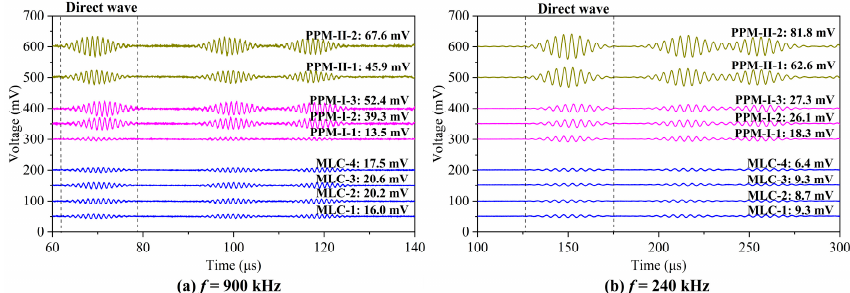
Figure 20. Received signals of the MLC and PPM EMATs at ( a ) 900 kHz and ( b ) 240 kHz.